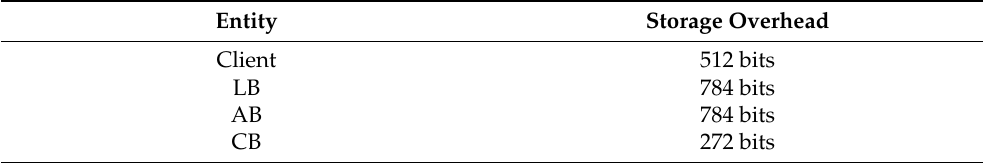
Table 5. Storage overhead for the client, LB, AB, and CB.